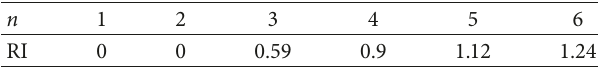
Table 2: Randomness index RI.